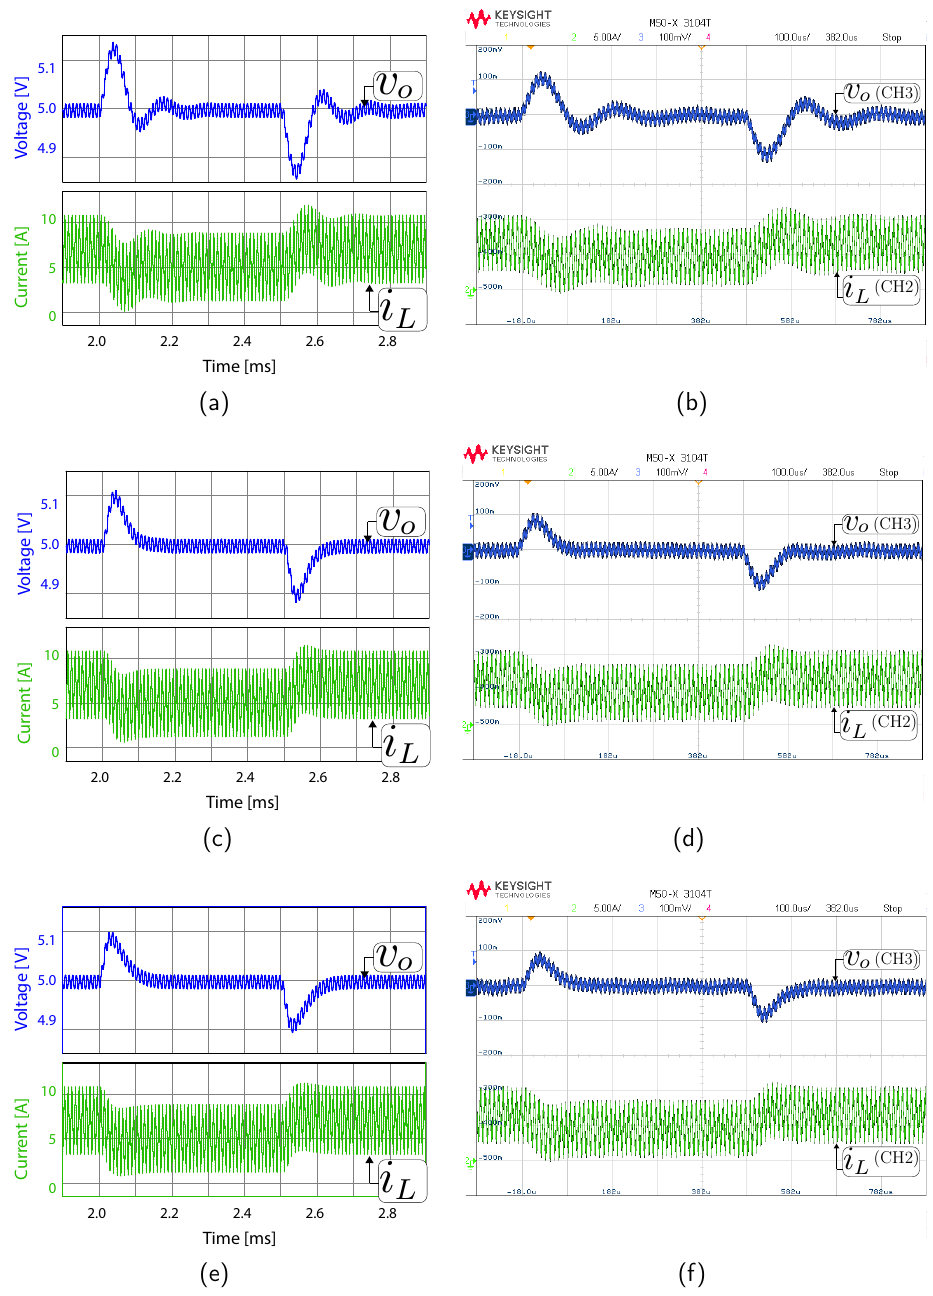
Figure 6. Output voltage and inductor current load regulation responses in closed voltage loop. The system is at steady-state with a load current of 7-A that is suddenly decreased to its nominal value of 5-A (1 Ω resistor) and, after voltage stabilization, is increased back to 7 A: ( a ) PSIM simulation, w = 0.5; ( b ) experimental measurement, w = 0.5; ( c ) PSIM simulation, w = 0.0; ( d ) experimental measurement, w = 0.0; ( e ) PSIM simulation, w = 0.5; and ( f ) experimental measurement, w = 0.5. − − In the oscillograms, CH1: output voltage v o (ac coupling, 100 mV/div), CH2: inductor current i L (dc coupling, 5